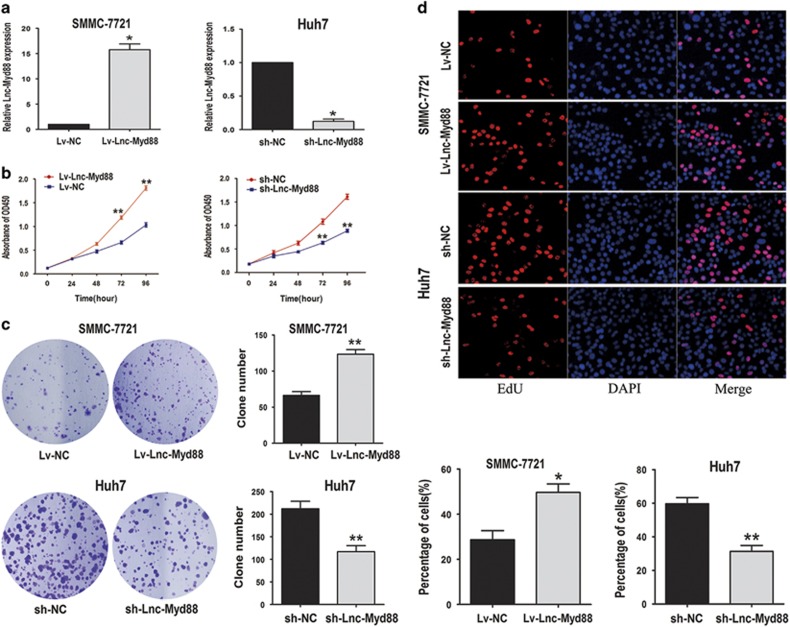
Lnc-Myd88 promotes HCC cells proliferation in vitro. (a) The transfection efficiency of ectopic expression and gene silencing of Lnc-Myd88 in SMMC-7721 and Huh7 cells was determined by qRT-PCR. (b) Proliferation ability was detected by CCK8 assay, overexpression of Lnc-Myd88 promoted SMMC-7721 cells proliferation, whereas knockdown of Lnc-Myd88 inhibited Huh7 cells proliferation. (c) Colony formation assays were performed on differently treated HCC cells for 2 weeks, representative graphs are shown. (d) EdU immunofluorescence staining confirmed the function of Lnc-Myd88 on HCC cells proliferation. Original magnification × 200. Stable overexpression of Lnc-Myd88 increased the proliferation of SMMC-7721 cells while knockdown of Lnc-Myd88 decreased the proliferation of Huh7 cells. All experiments were performed in triplicate and presented as the mean±S.E.M. (*P<0.05, **P<0.01)